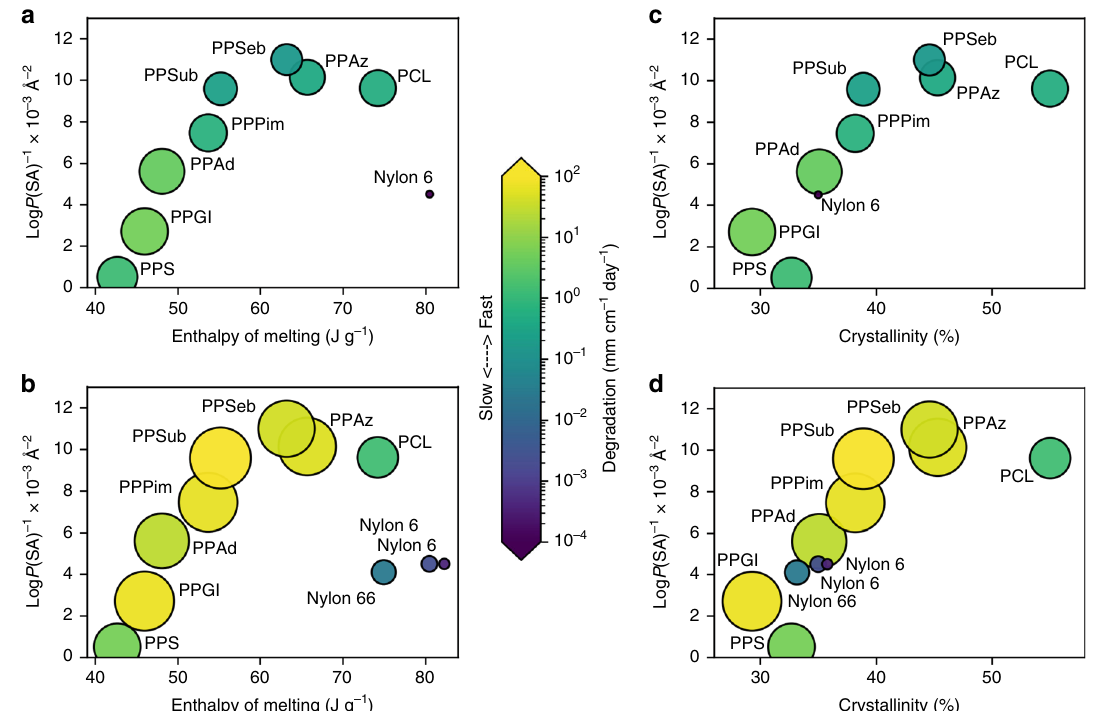
Fig. 2 In fl uence of crystallinity and hydrophobicity on degradation. Computational Log P (SA) -1 values versus a enthalpy of melting for abiotic hydrolysis, b enthalpy of melting for biotic processes, c % crystallinity for abiotic hydrolysis, d % crystallinity for biotic processes. Size of circles and color corresponds to surface erosion in mg cm − 2 day − 1 in arti fi cial